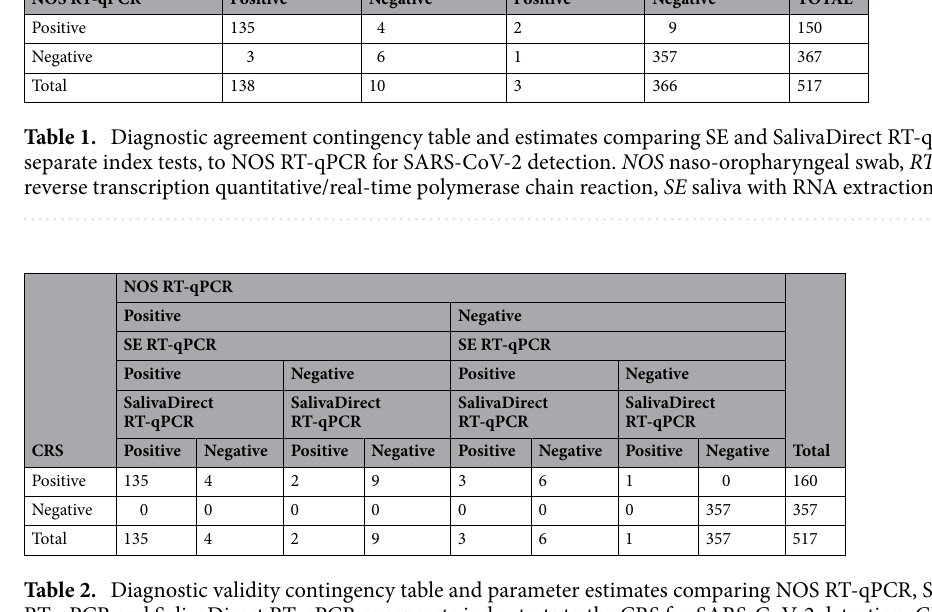
Table 2. Diagnostic validity contingency table and parameter estimates comparing NOS RT-qPCR, SE RT-qPCR and SalivaDirect RT-qPCR as separate index tests to the CRS for SARS-CoV-2 detection.